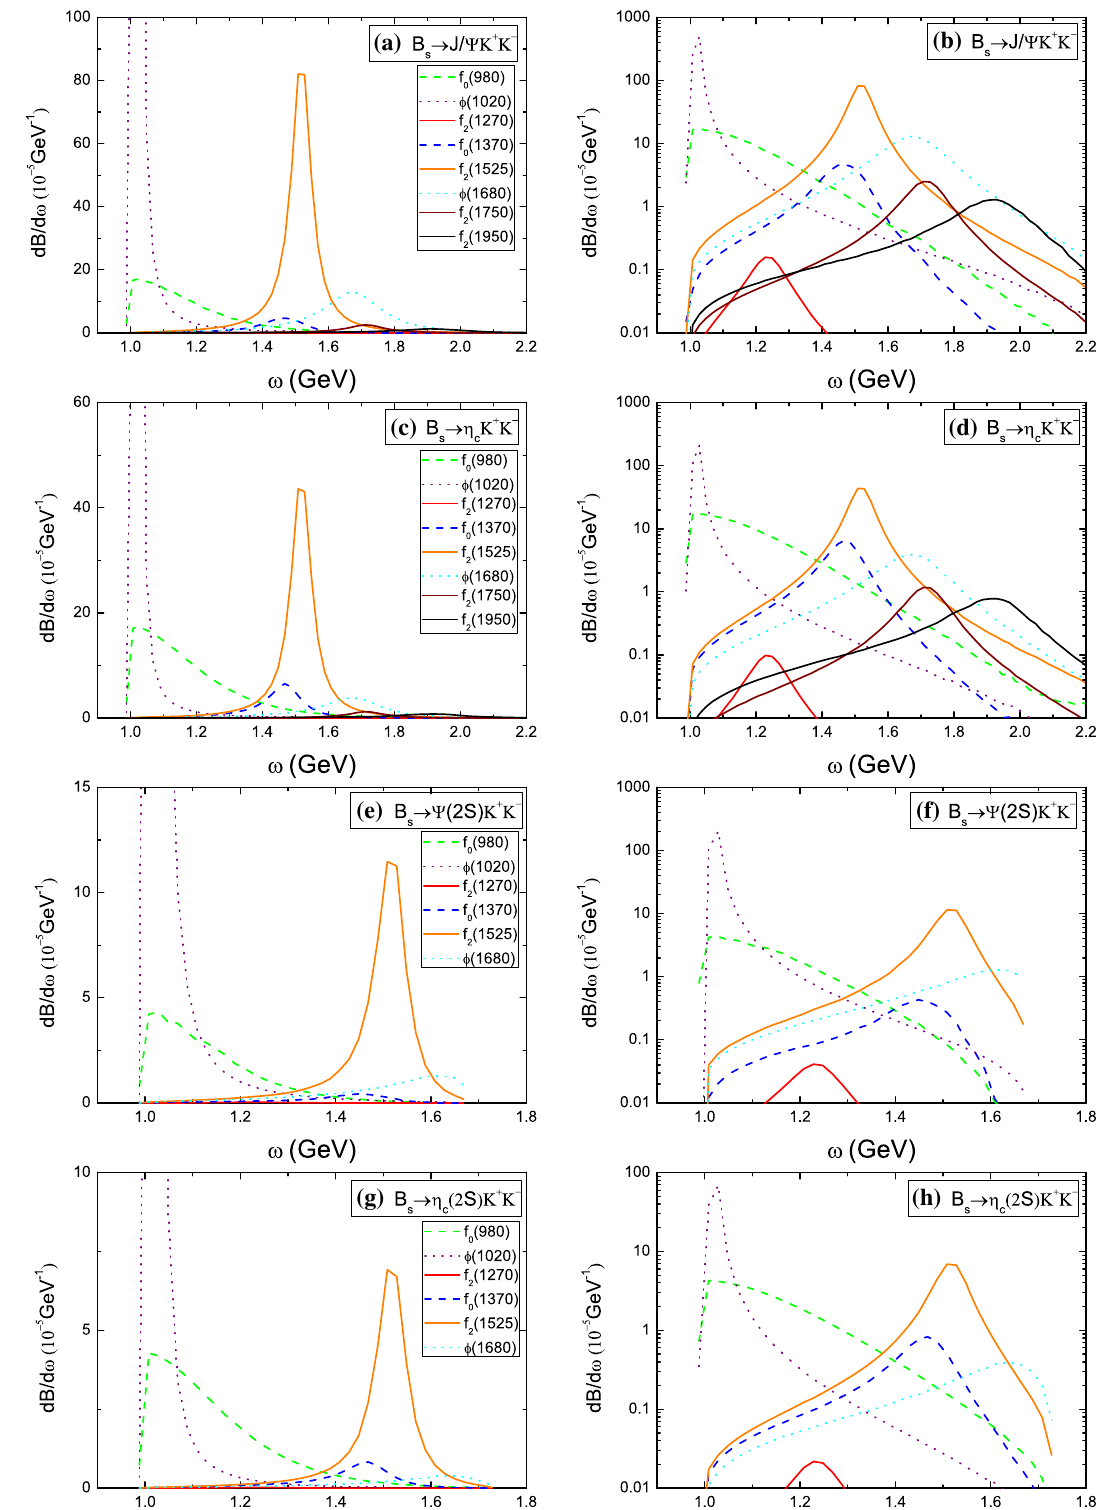
Fig. 3 Various resonance contributions to the differential branching ratios of the modes a B s → J /ψ K + K − , c B s → η c K + K − , e B s → ψ( 2 S ) K + K − , and g B s → η c ( 2 S ) K + K − with a linear scale.